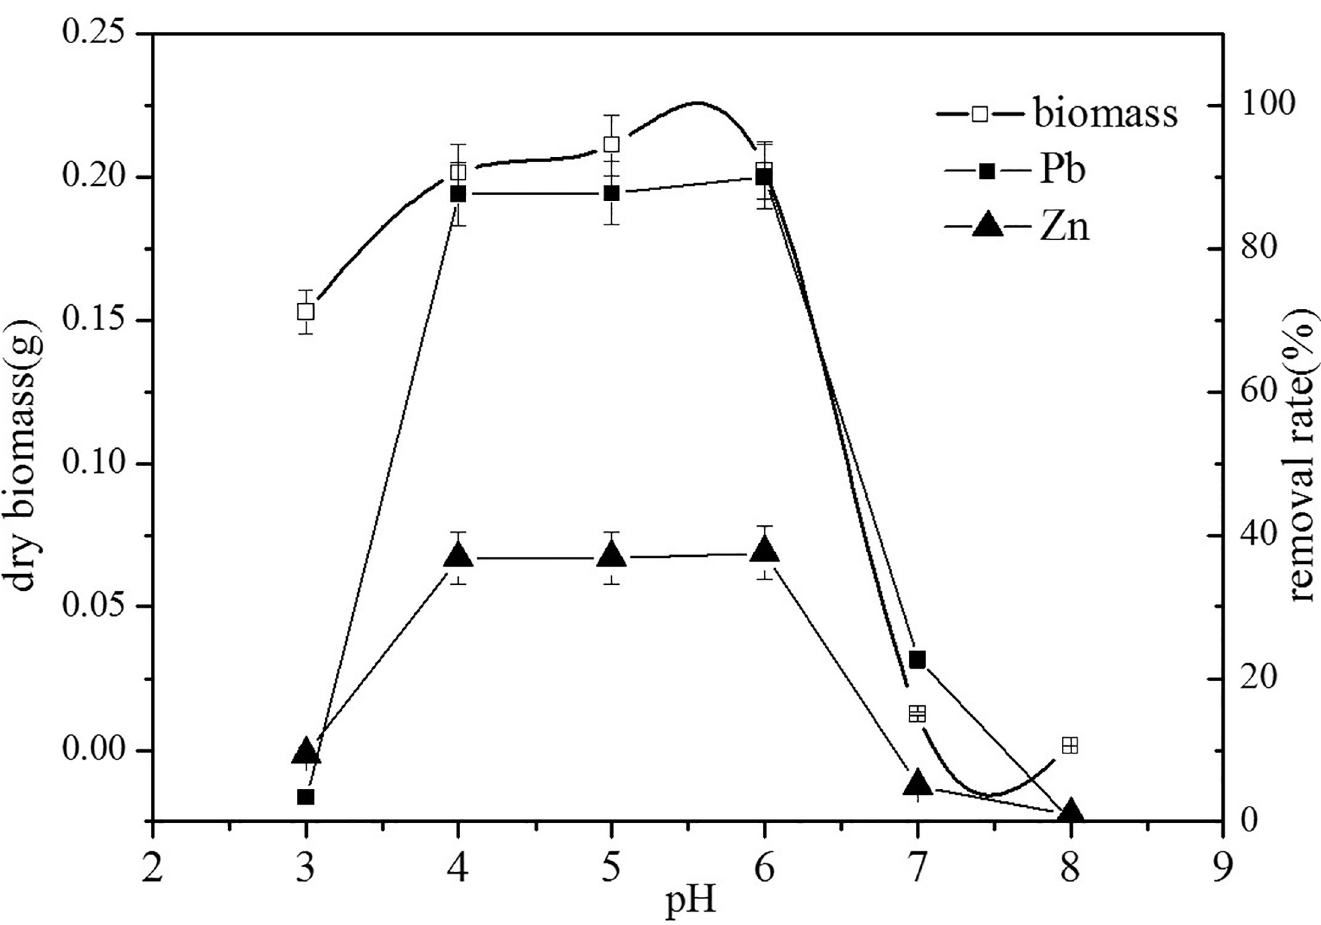
Fig 1. The effects of initial pH on biosorption and the biomass of Verticillium insectorum J3. Biosorption conditions: initial Pb(II) and Zn(II) concentration in solution 250 mg L -1 , absorption time 7 days, initial biomass does 2mL L -1 , temperature 30˚C. (Error bar represents means ± SE, P < 0.05, and n = 3).